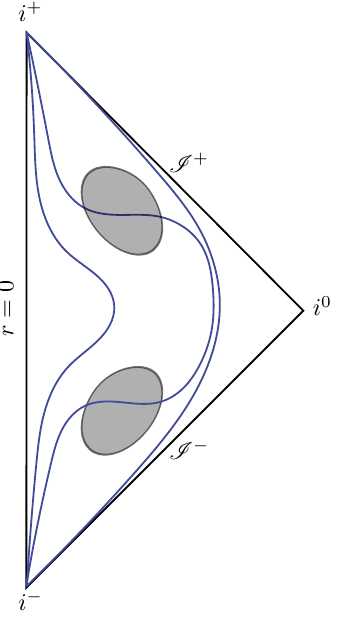
Figure 5. Causal diagram of a bouncing geometry. The lower shaded region is a black-hole-like trapped region, while the upper one is a white-hole-like trapped region. The blue curves joining i − and i + qualitatively represent r = const.